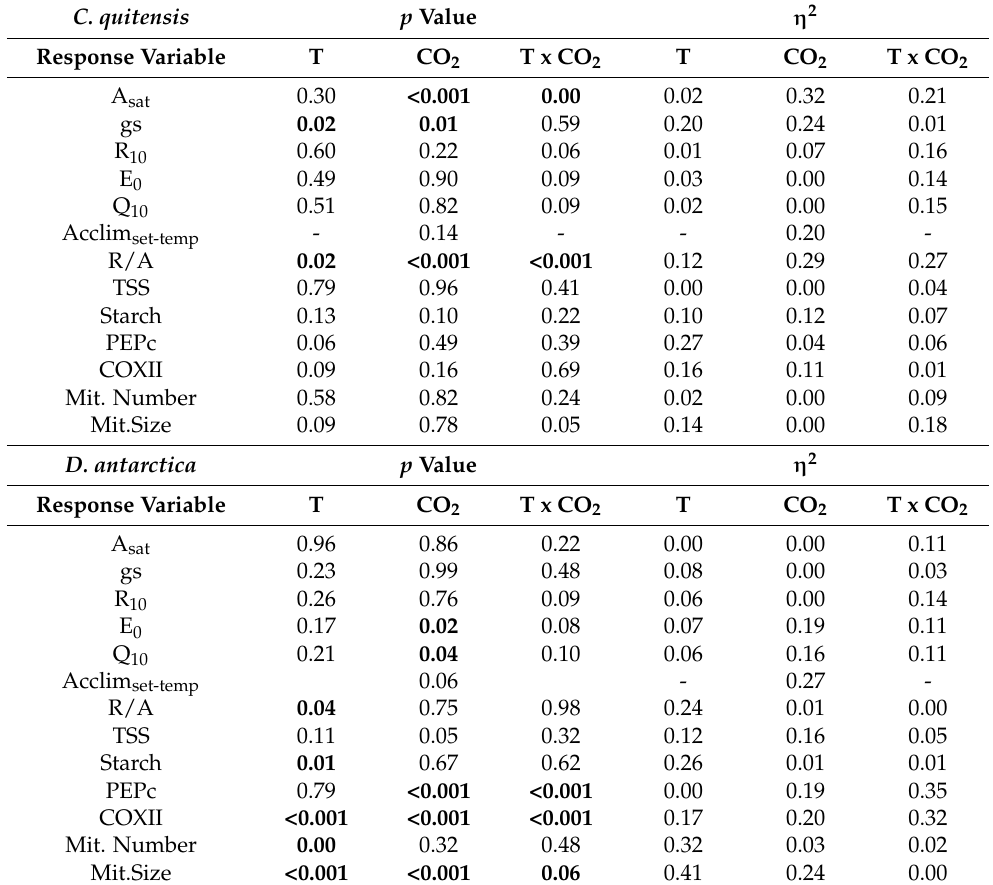
Table 1. Results of two-way ANOVA and the size effects ( η 2 ; Eta squared) of each evaluated factor. The response variables were net CO 2 assimilation at saturating light and 400 ppm of CO 2 (A sat ), stomatal conductance ( gs ), dark respiration at 10 ◦ C (R 10 ), activation energy of respiration (E 0 ), ther- mal sensitivity of respiration (Q 10 ), thermal acclimation of respiration (Acclim set-temp ), foliar carbon balance (R/A), total soluble sugar concentrations (TSS), starch concentrations, phosphoenol-pyruvate carboxylase (PEPc) concentrations, cytochrome oxidase (COXII) concentrations, mitochondrial num- ber, and mitochondrial size. Significant effects ( p < 0.05) are indicated in bold. The η 2 values were calculated from information in the ANOVA table as η 2 = Treatment sum of square/ (treatment sum of square + total sum of